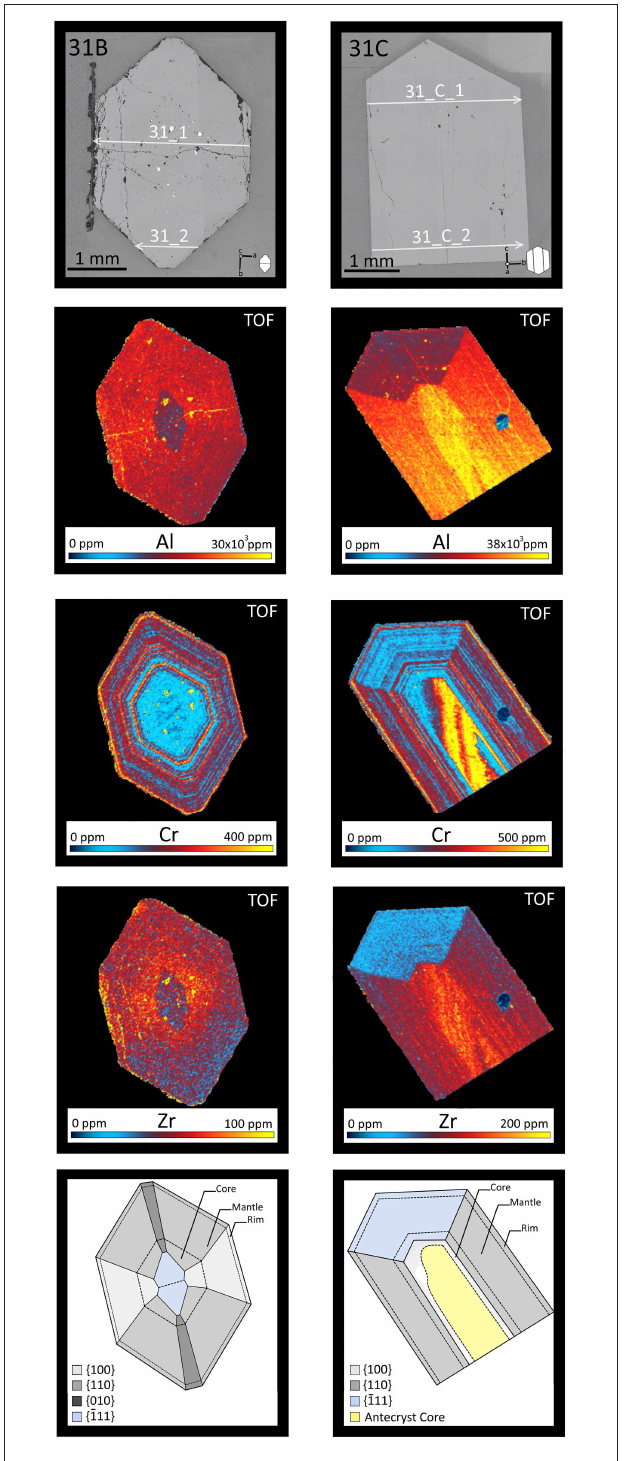
FIGURE 5 | Reflected light scans and LA-ICP-TOFMS maps of crystal 31, cut perpendicular to the c -axis (section 31B) and along the c -axis (section 31C). This crystal has a perfect polyhedral habit ( Figure 2 ) and was used to build the models in Figure 3 . Chromium shows the largest variations across the crystal, defining a homogeneous, depleted core ( ∼ 100 ppm), a finely oscillatory zoned (Continued)